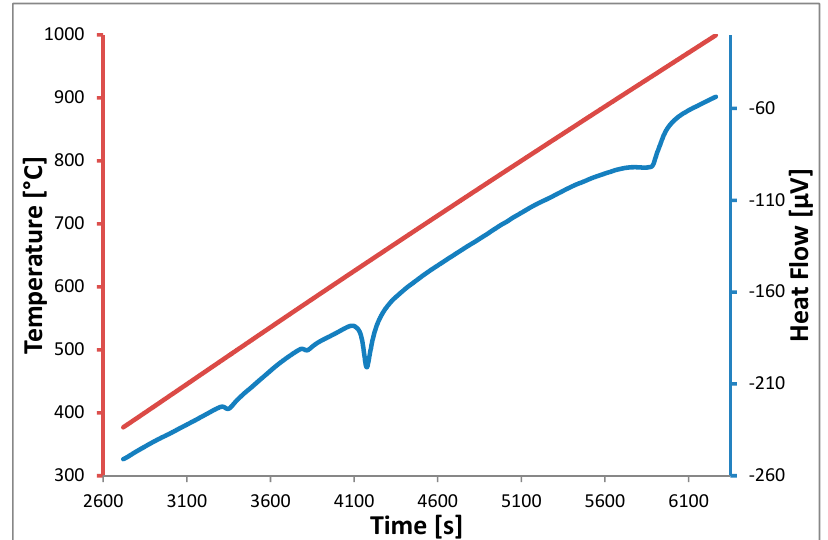
Figure A1. Experimental DSC signal of a representative heating cycle of a NaF-UF4 sample with X(UF4) = 10mol%. The four equilibria are at 737 ± 5 K formation of Na3[UF7], at 825 ± 5 K α – β transition of Na3[UF7], at 887 ± 5 K eutectic equilibrium and at 1201 ± 15 K liquidus point. Table A1. Intermediate NaF-UF 4 compositions subjected to DSC measurements within this study. Nr.